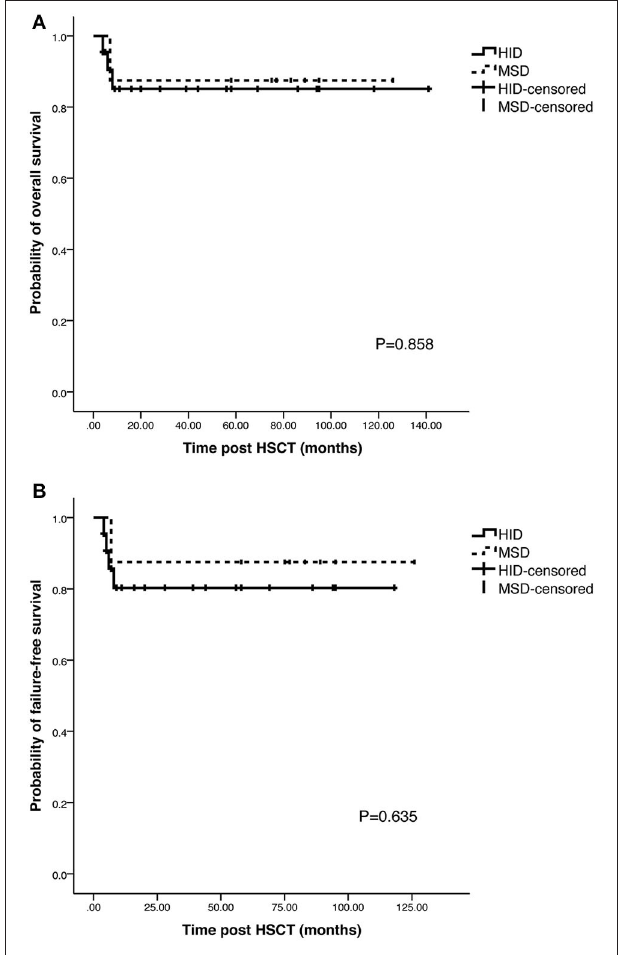
FIGURE 4 | Cumulative incidence of cytomegalovirus (CMV) and Epstein-Barr virus (EBV) infection in HID and MSD cohort. (A) Cumulative incidence of CMV infection. (B) Cumulative incidence of EBV infection.